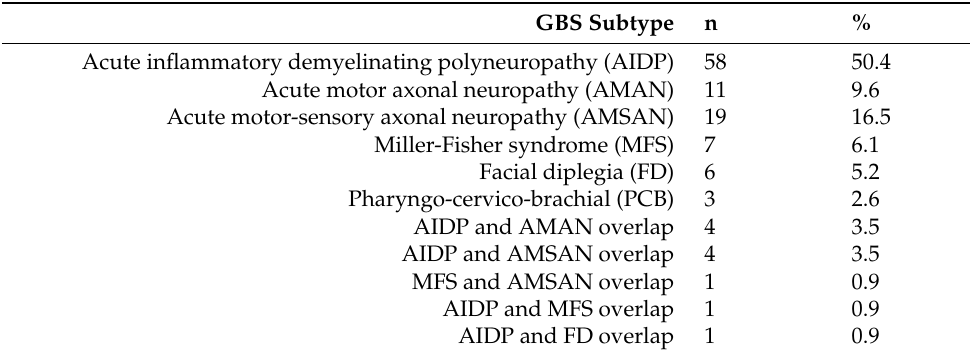
Table 3. Distribution of Guillain–Barr é syndrome